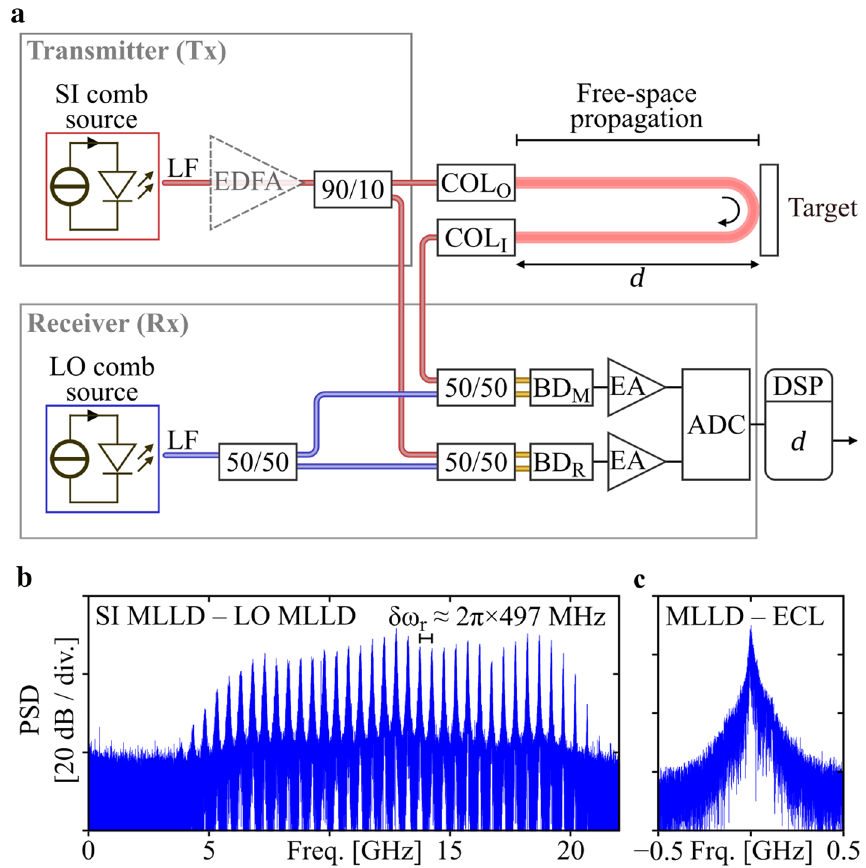
Figure 2. Experimental setup and measured RF spectra of our proof-of-concept demonstration. ( a ) Experimental setup: In the transmitter (Tx), the signal (SI) comb generated by a first MLLD is coupled into a lensed fiber (LF), optionally amplified in an EDFA (dashed lines), and then split by a 90/10 coupler. A first portion is emitted towards the target through an output collimator (COL O ). After free-space propagation and reflection at the target, the comb re-enters the system at the input collimator (COL I ). In the receiver (Rx), the captured light is sent to a 50/50 coupler where it is superimposed with a first portion of the local